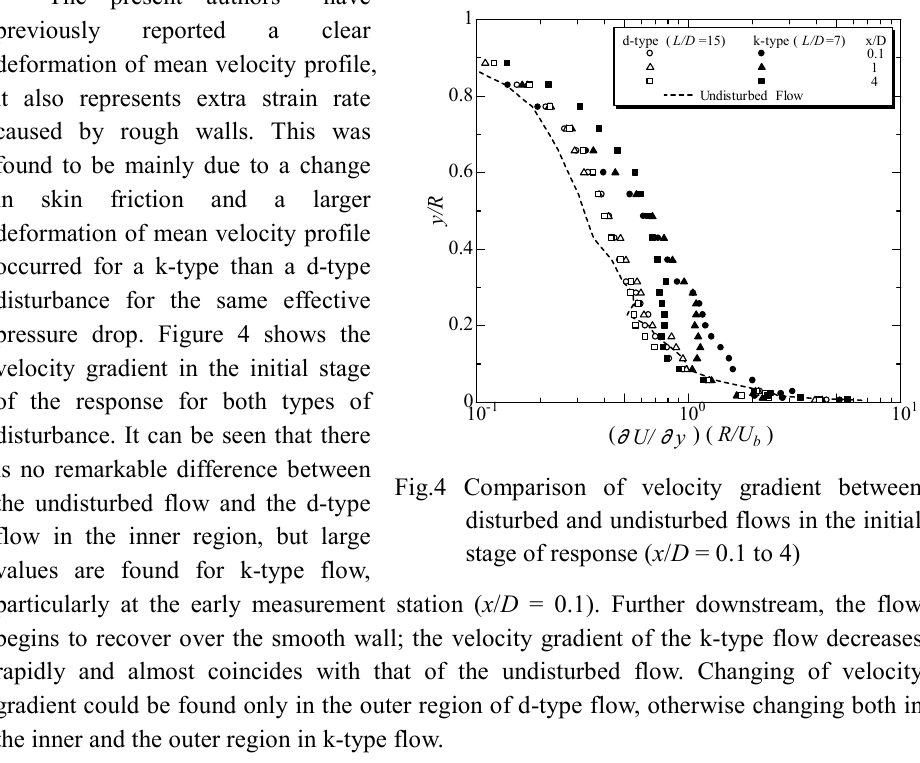
Fig.3 Energy thickness of disturbed and undisturbed flows